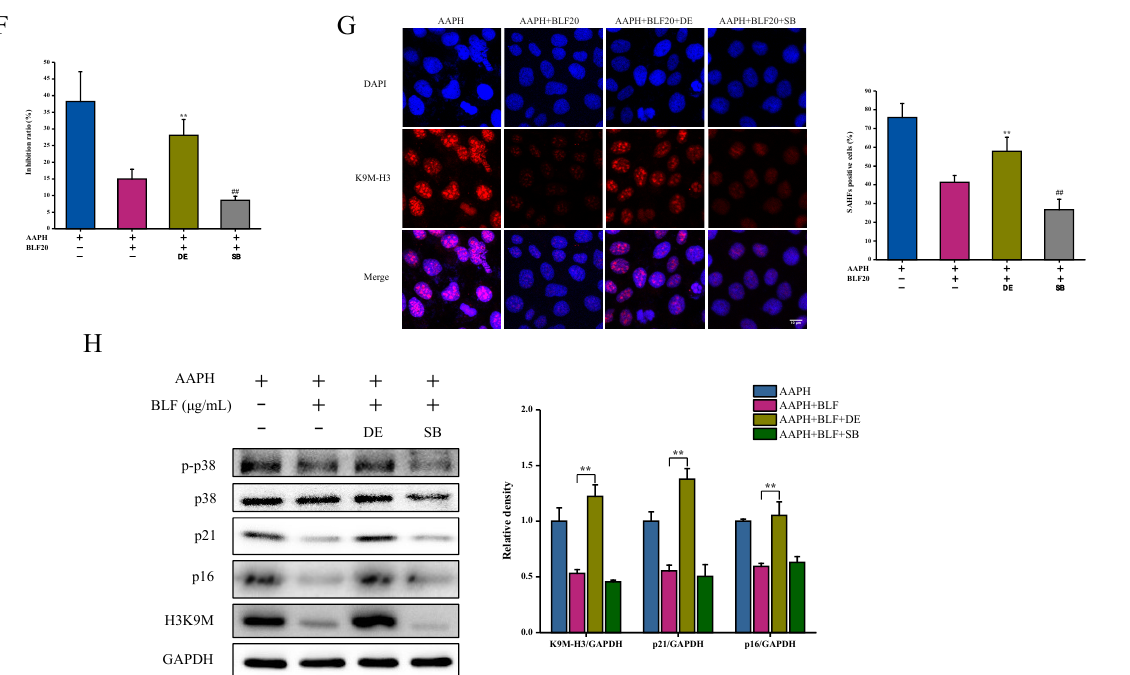
Figure 4. BLF inhibited AAPH-induced cellular senescence by regulating p38 MAPK signaling. ( A ) The analysis and screening of differential expressed genes (DEGs) in the control group, AAPH- treated group and AAPH and BLF co-treated group. ( B ) Cluster of DEGs in each group. ( C ) KEGG enrichment analysis of DEGs between the AAPH-treated group and AAPH and BLF co-treated group. ( D ) Normalized MAPK-related DEGs in each group. ( E ) Protein expression of p-p38, p38, p-JNK, JNK, p-ERK, and ERK determined by Western blotting ( left ). Quantitation is shown on the right. ** p < 0.01 vs. AAPH treated group. ( F ) HaCaT cells were pretreated with 10, 20, and 40 µ g/mL BLF, 100 nM dehydrocorydaline (DE), or 10 µ M SB203580 (SB) for 1 h, and then co-incubated with 1 mM AAPH for another 48 h. The proliferation inhibition of HaCaT cells determined by the MTT assay after DE and SB treatment in HaCaT cells. ( G ) Representative images of SAHF formation photographed by confocal microscope. Scale bar = 10 µ m. The percentage of SAHF positive cells is shown in the right panel. ( H ) Protein expression of p21, p16, and K9M-H3 determined by Western blotting after DE and SB treatment in HaCaT cells. ( left ). Quantitation is shown on the right. ## p < 0.01, ** p < 0.01 vs. AAPH-treated